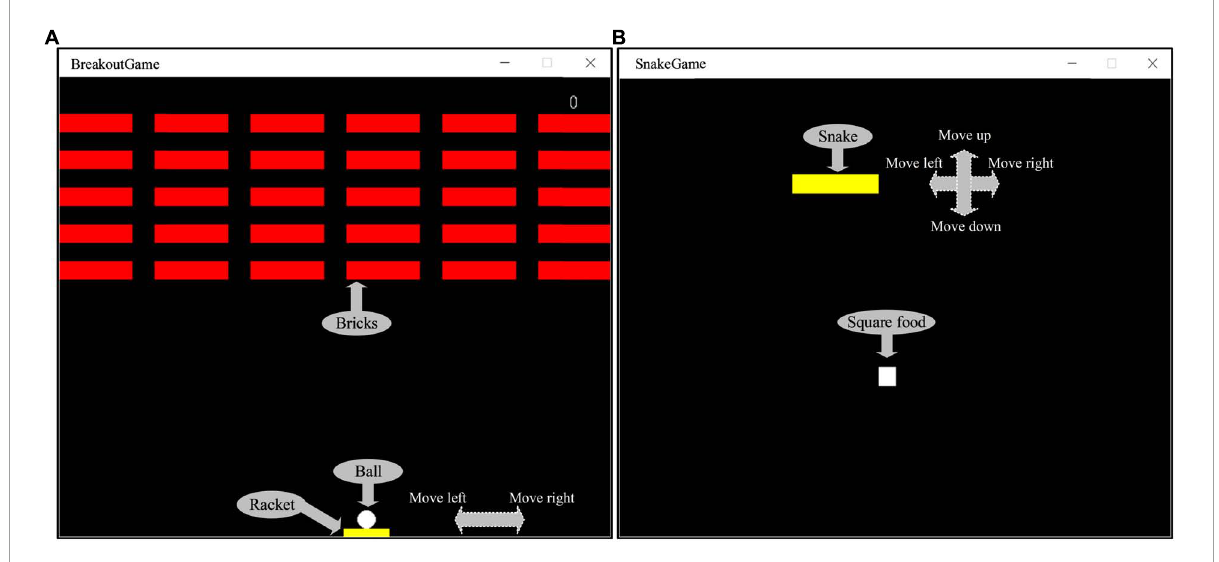
FIGURE5 (A) The Breakout game interface. (B) The Snake game